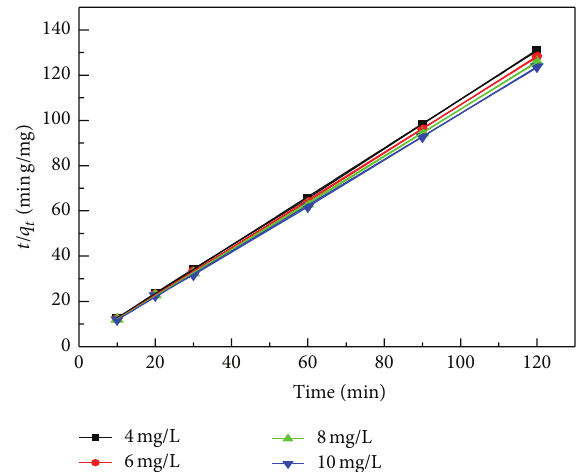
Figure 8: Pseudo-second-order kinetics plot for adsorption of MB on C. polygonoides ash.